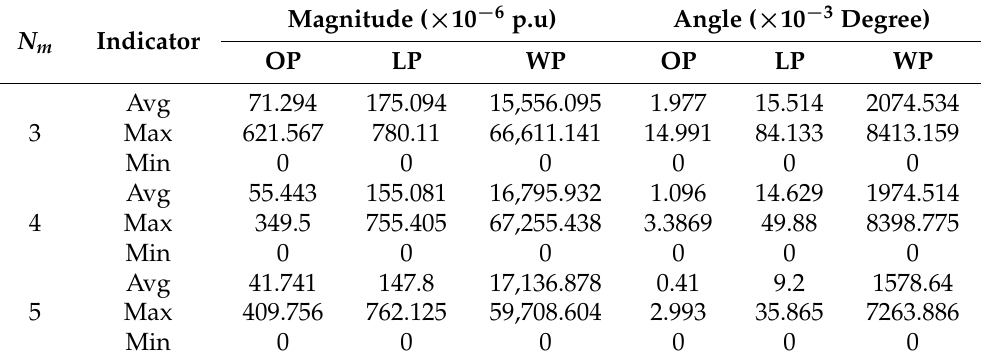
Table 5. State estimation error—33-bus